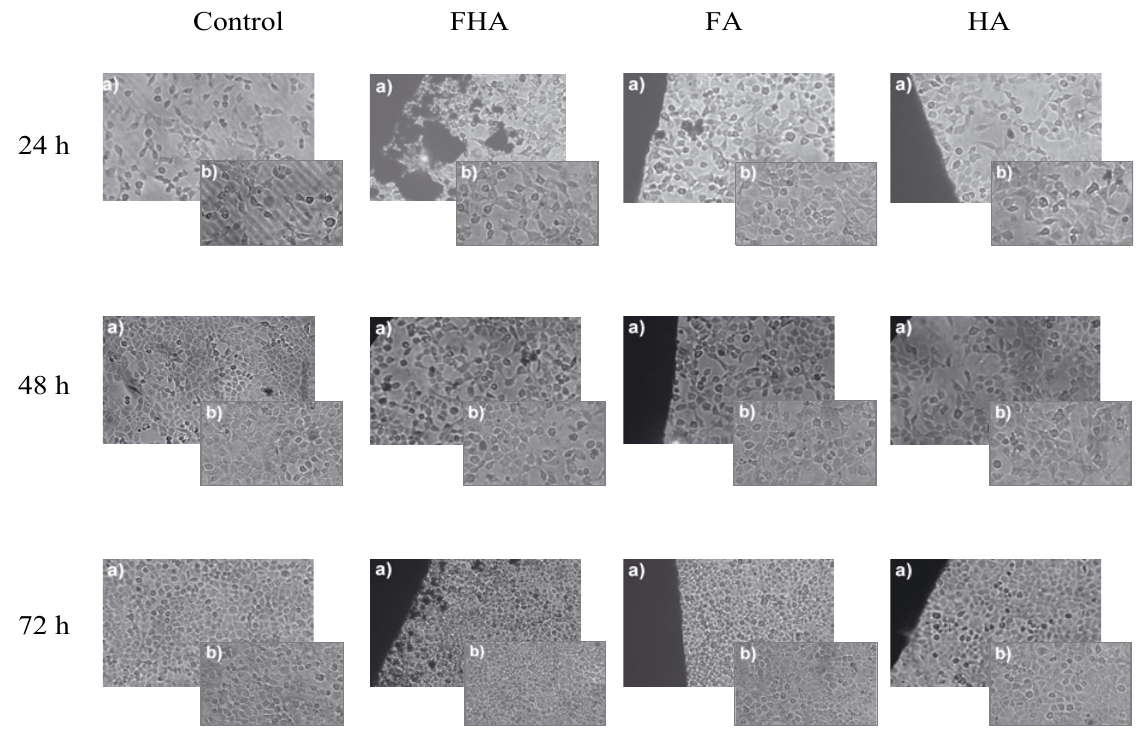
Figure 5. Morphological analysis of NIH-3T3 cells cultured for 24, 48 and 72 hours in presence of FHA, FA and HA. The microscopic observations are carried out starting from the centre where the materials are located to the periphery of the dish. Magnification: a) 80x; b)